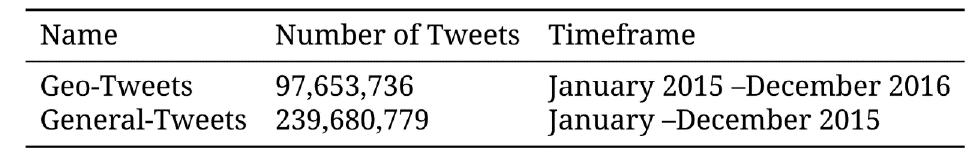
Figure 1. Characteristics of Twitter